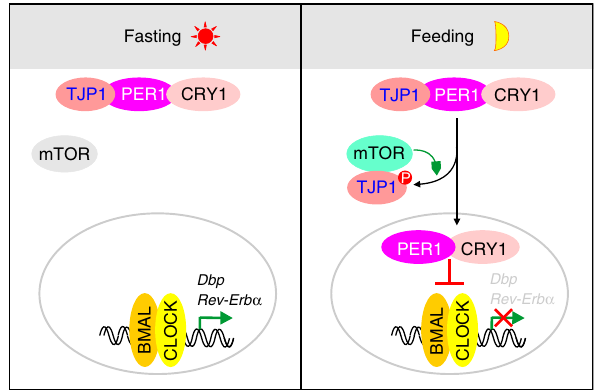
Fig. 8 TJP1 couples mTOR signaling to the hepatic circadian clock. During fasting or in daytime, mTOR is less active and cannot disrupt the association of TJP1 and PER1/CRY1, which sequesters PER1/CRY1 in the cytoplasm. During feeding or at nighttime, active mTOR phosphorylates and interacts with TJP1, disrupts its interaction with PER1/CRY1 and promotes nuclear translocation of PER1/CRY1, which inhibits CLOCK: BMAL-dependent